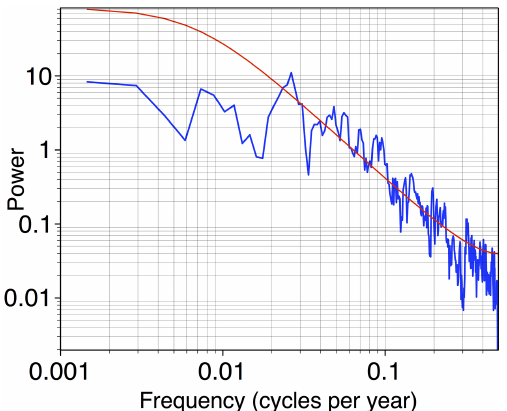
Figure 9. Multi-taper method (MTM) spectrum of the median sta- lagmite δ 18 O time series. The red line denotes the 99% confidence intervals for an AR(1) red noise model calculated from the 10FC- 02 stalagmite time series. The MTM analysis was performed using the K-Spectra software package (http://www.spectraworks.com/). The MTM spectrum contains significant concentrations of power throughout the interannual and multidecadal bandwidth.